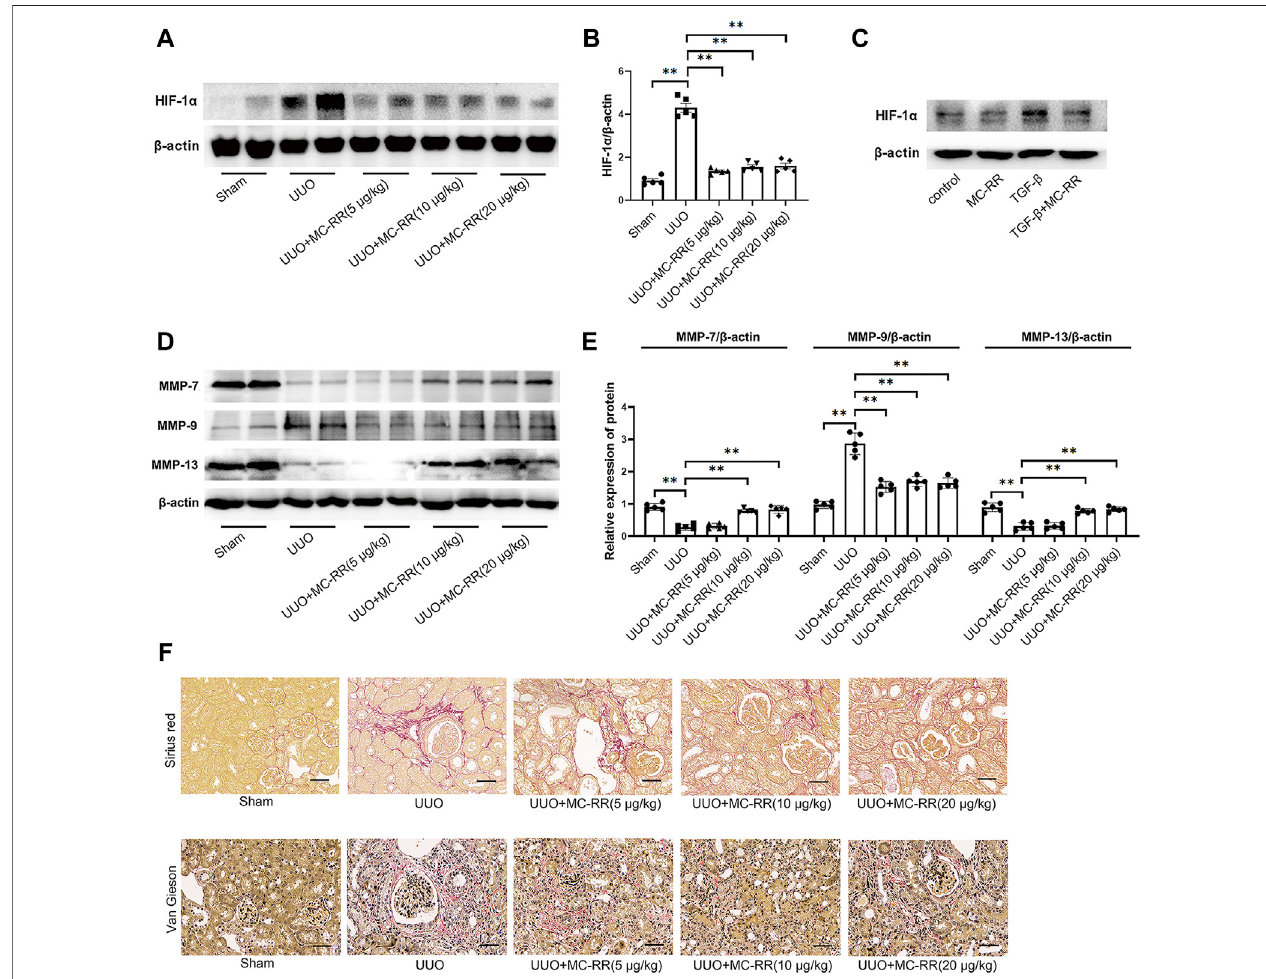
FIGURE 5 | Microcystin (MC)-RR inhibits the expression of hypoxia inducible factor 1 subunit alpha (HIF-1 α ) and alters the level of matrix metalloproteinases (MMPs).Unilateralureteralobstruction(UUO)miceandtheculturedNRK-49Fcellsweretreatedasdescribedin Figure2 and Figure4 ,respectively. (A,B) Expressionof HIF-1 α proteininthekidneytissueswasdetectedbywesternblot. (C) LevelofHIF-1 α inNRK-49Fcellswasdeterminedbywesternblot. (D,E) ExpressionlevelsofMMP- 7,MMP-9, andMMP-13 inthekidneytissuesofUUO micewereanalyzedbywesternblot. (F) Depositionofcollagenandelastic fi bersinthekidneytissues ofUUO micewithMC-RRtreatment wasevaluatedbySirius Redstainingand VanGiesonstaining(scalebar: 40 μ m).* p < 0.05, ** p < 0.01determined byone-wayANOVA with S – N – K post hoc analysis, n = 5.